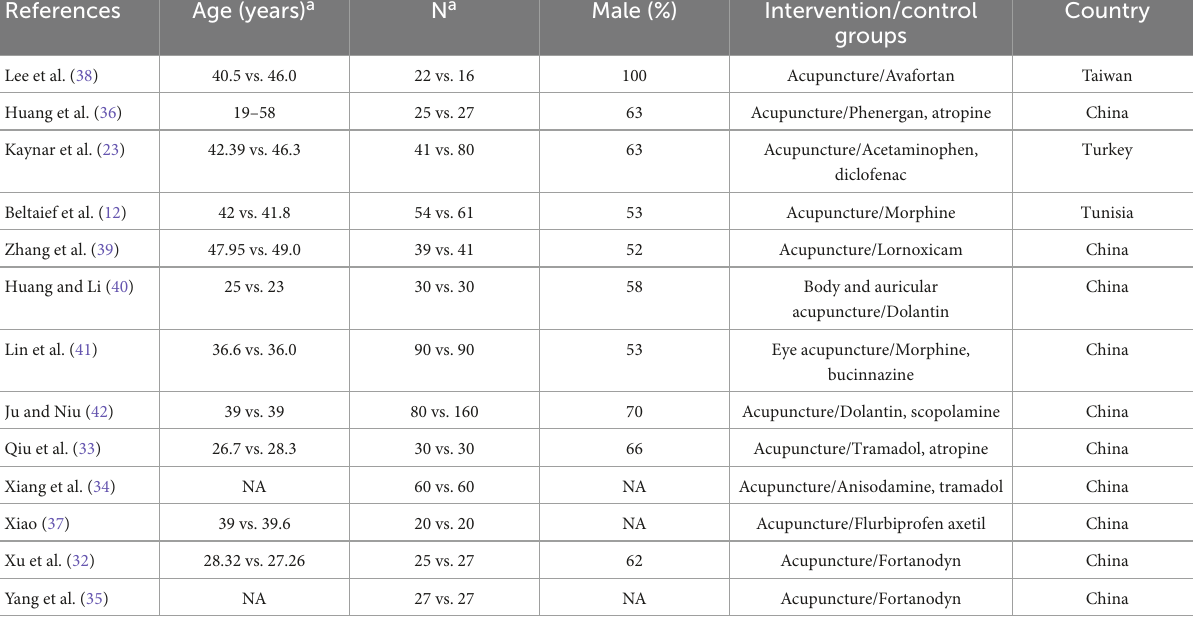
TABLE 1 Characteristics of studies ( n = 13).